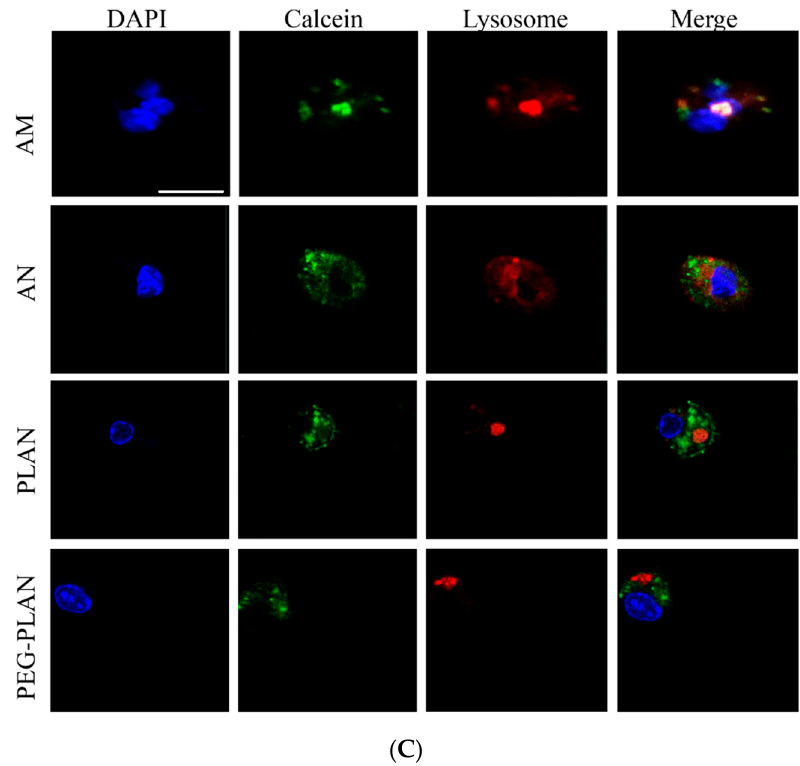
Figure 3. Activation of APCs stimulated by the Al-based VADSs and lysosome escape of the Al-based VADSs. ( A , B ) The expression levels of activation biomarkers (CD40, CD80, and CD86) on BMDCs after stimulation with the Al-based VADSs were obtained by flow cytometry assay of the cells stained with fluorescent-labeled Abs. (* p -value < 0.05, ** p -value < 0.01). ( C ) Intracellular locations of calcein-loaded Al-VADSs in APCs with 4’,6-diamidino-2-phenylindole (DAPI)-labeled nucleus (blue) and LysoTrack-red labeled lysosomes (red) were mapped with laser scanning confocal microscopy (LSCM) (bar = 10 µ m, applicable to all panels).